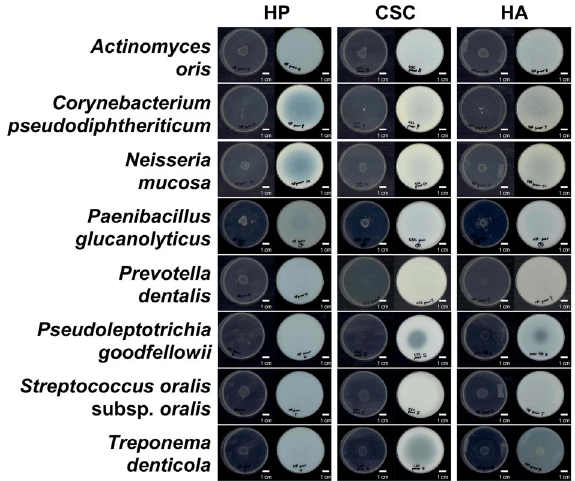
Figure 1. Glycosaminoglycan (GAG) degradation by typical oral bacteria. Eight typical oral bacterial species from different genera were grown on the center of the halo-forming minimal medium plate containing heparin (HP) (left), chondroitin sulfate C (CSC) (middle), or hyaluronan (HA) (right). After full growth on the medium plate (left), acetic acid was spread onto the plate for halo formation (right). Bar, 1 cm. Only N. mucosa degraded HP. P. goodfellowii and T. denticola degraded CSC and